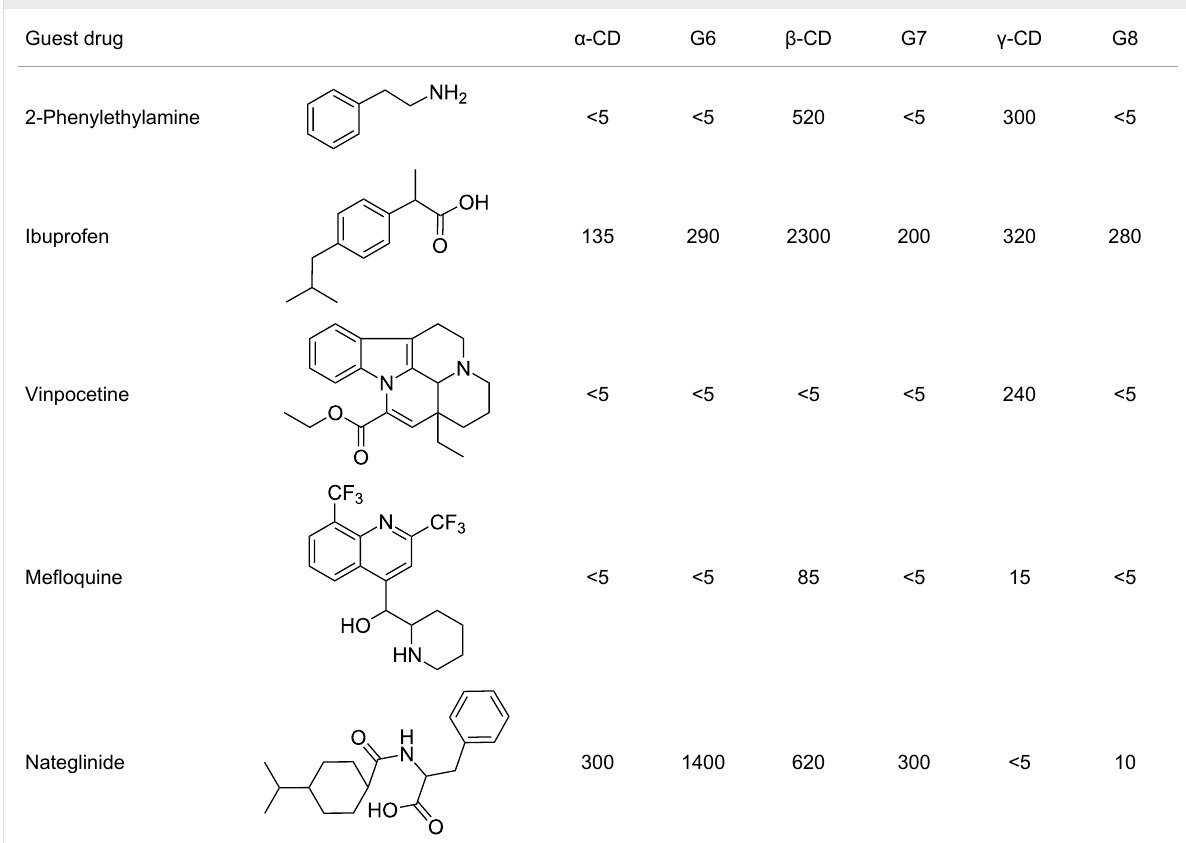
Table 1: K app values of different dextrin-drug systems (25 °C).